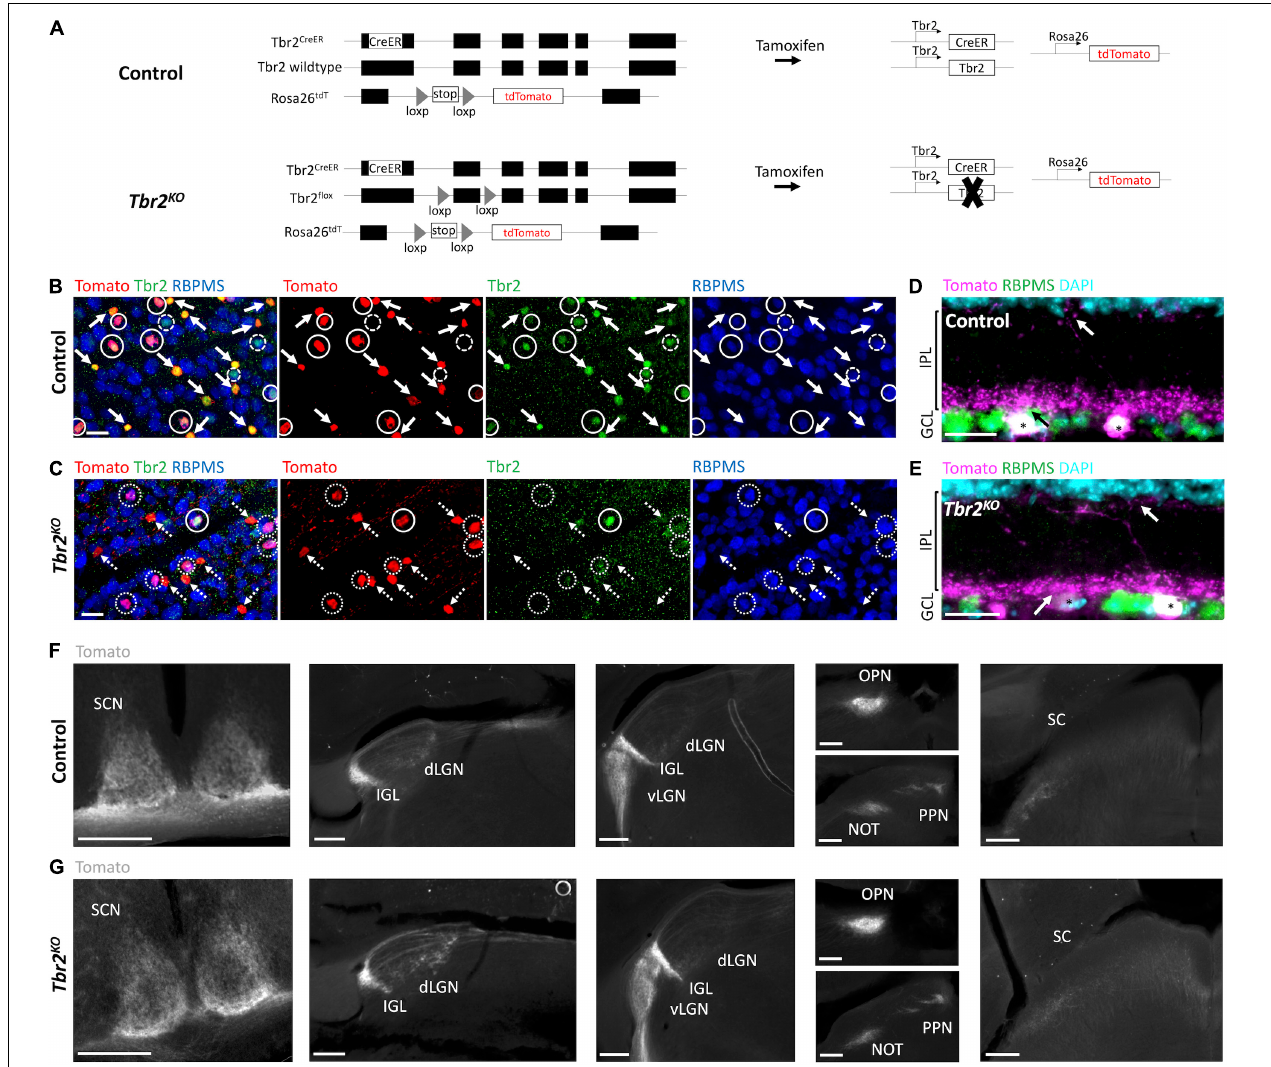
FIGURE 1 | Tbr2 CreER recapitulates endogenous Tbr2 expression and loss of Tbr2 does not alter dendritic stratification or axon projections of Tbr2 expressing neurons. (A) Schematic of genetic strategy used to remove Tbr2 from Tbr2 + cells in adulthood while simultaneously fluorescently labeling them. Black boxes are exons, thin lines are non-coding regions. (B,C) Flatmount view, GCL side up, of a retina derived from a Tbr2 CreER / + ;tdT (control, B ) or Tbr2 CreER / flox ;tdT ( Tbr2 KO , C ) P60 mouse immunostained to reveal expression of Tomato (red), Tbr2 (green), RBPMS (blue) with the first image being a merge of all markers; solid circles represent Tbr2 + Tomato-labeled RGCs, solid arrows point to Tbr2 + Tomato-labeled amacrine cells (lack RBPMS expression), dashed circles indicate Tbr2 + RGCs that do not express Tomato, dotted circles indicate Tomato-labeled RGCs that do not express Tbr2, and dashed arrows point to Tomato-labeled amacrine cells that do not express Tbr2; scale bar = 25 µ m. While 98% of wildtype Tomato + RGCs express Tbr2 (B) , only 15% express Tbr2 in the mutant (C) . (D,E) Section of a control (D) and Tbr2 KO (E) mouse retina immunostained to reveal expression of Tomato (magenta), RBPMS (green), DAPI (cyan); scale bar = 25 µ m. There is no difference in the localization of Tomato + dendrites between these mice (arrows indicate dendrites of Tomato + RGCs (asterisks) in the innermost and outermost sublaminae of the IPL). (F,G) Comparison of the axonal trajectories of Tomato-labeled RGCs in control (F) and Tbr2 KO (G) mice. Coronal sections reveal that Tomato + RGCs innervate the SCN, dLGN, IGL, vLGN, OPN, PPN, and deep SC in controls (F) and maintain this innervation in Tbr2 KO mice (G) . Scale bars = 250 µ m. GCL, ganglion cell layer; IPL, inner plexiform layer; INL, inner nuclear layer; SCN, suprachiasmatic nucleus; dLGN, dorsal lateral geniculate nucleus; IGL, intergeniculate leaflet;